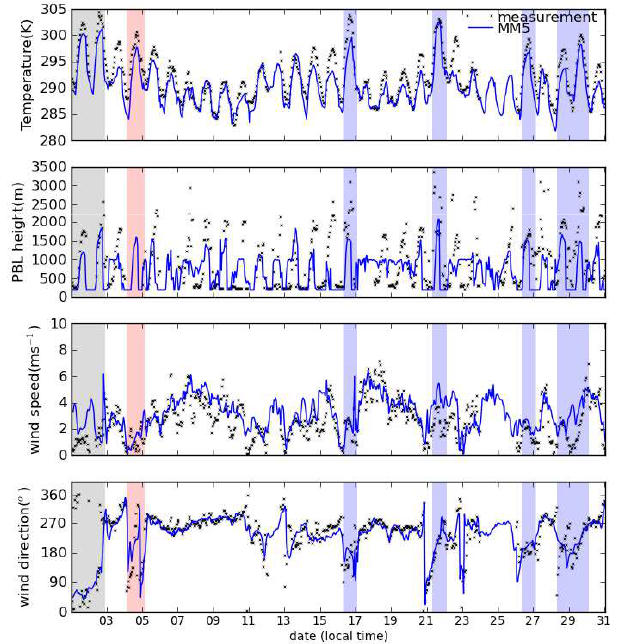
Fig. 2. Comparison of simulated (blue lines) and observed (black dots) temperature, boundary layer (PBL) height, wind speed, and wind direction at SIRTA; the grey bar represents the period R1 during a continental regime; the red bar the R2 period during the local regime; the blue bar the R3 regime with southerly advection; white background indicates the Atlantic regime (R4).